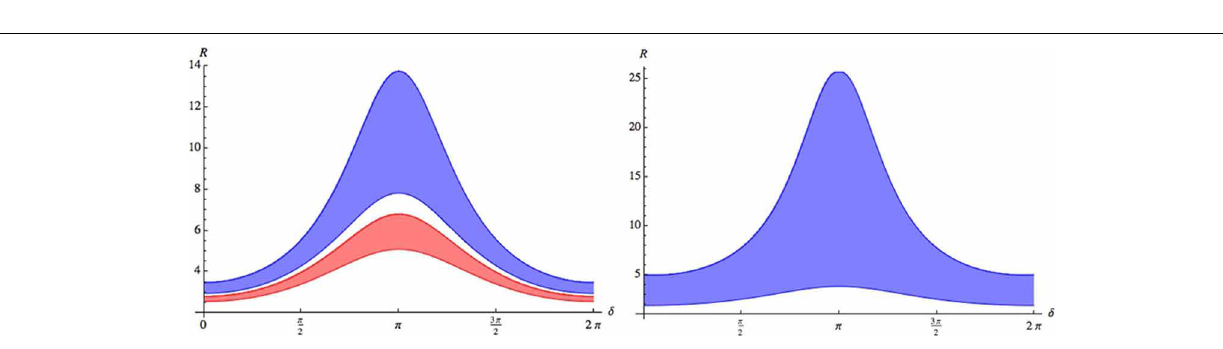
vs. the CP phase δ for neutrino mixing FIGURE 2 | R ν e : ν μ angles [15] at 1 σ (left panel) and at 3 σ (right panel). For the 1 σ case we show two regions: one for θ 23 in the 1st octant (orange